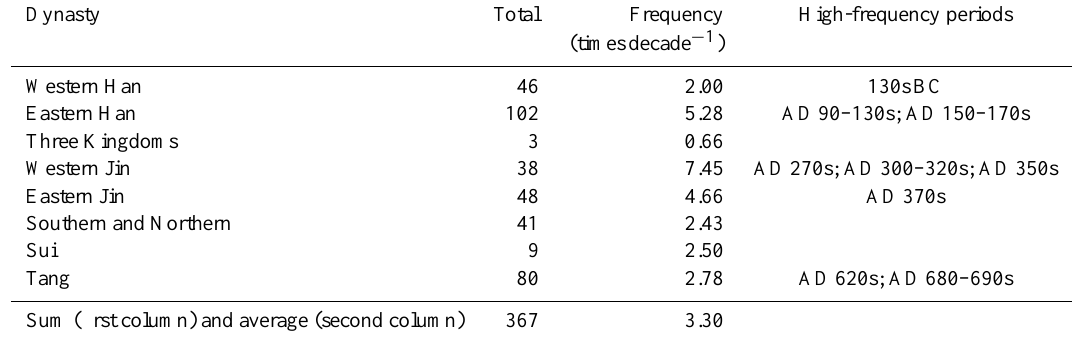
Table 2. Frequency of war initiation and victories of the farming and the nomadic groups. Farmers Nomads Dynasty Total Percentage Total initiation victories Eastern Han Three Kingdoms Eastern Jin Southern and